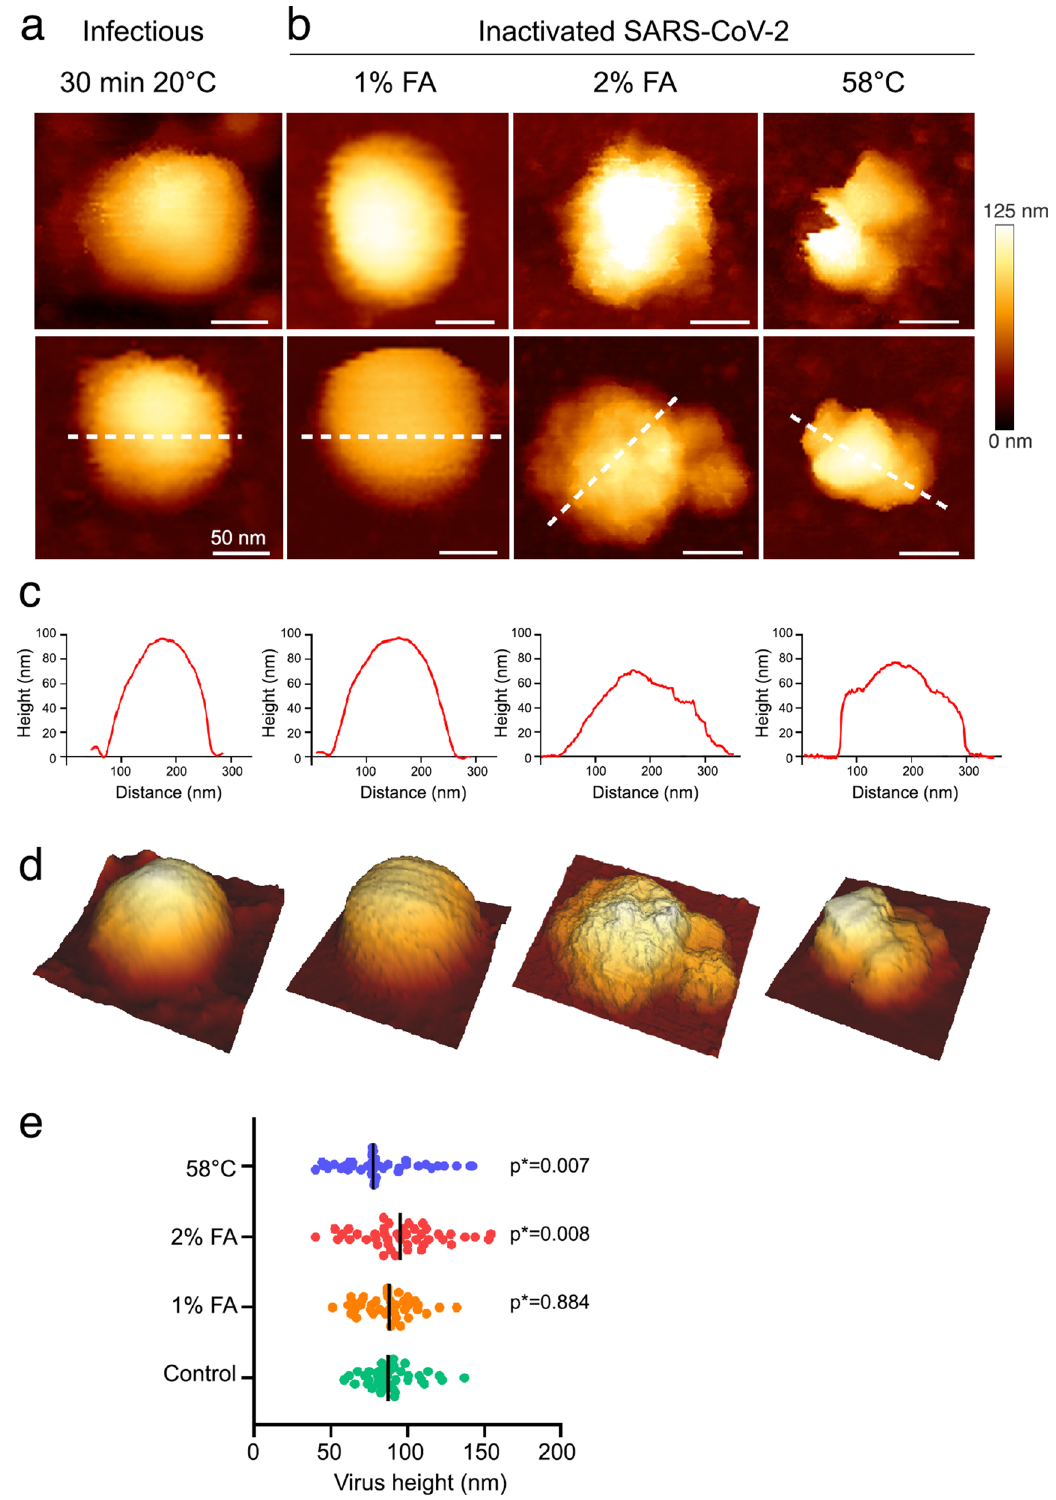
Figure 2. SARS-CoV-2 inactivation monitored by topographic imaging using QI mode AFM in buffer. (a ) Native infectious, control SARS-CoV-2 sample kept for 30 min at room temperature. ( b ) Virus particles inactivated with 1% and 2% FA for 30 min at 20 °C, or incubated at 58 °C for 30 min. Scale bars are 50 nm. The color gradient for Z scale is the same for all AFM panels. ( c ) Topographical profile plots measured along the dotted lines in the lower panel in ( a ). ( d ) 3D projection of the particles in the lower panel ( a ). ( e ) Distribution of the topographical maximal height of treated and untreated SARS-CoV-2 particles (control n = 39; 1% FA n = 40; 2% FA n = 43; 58 °C n = 39). P values are indicated and were computed by using two-sided independent t tests and comparing the results to those for the untreated